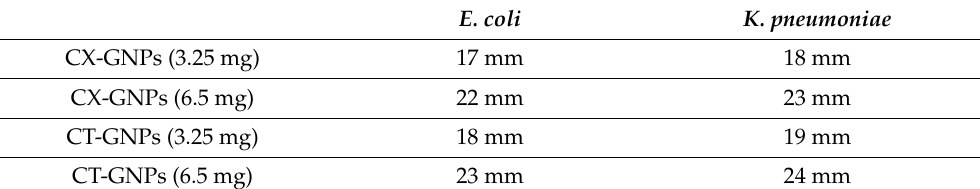
Table 1. : Inhibition zones of CT-AuNPs and CX-AuNPs against E. coli and K. pneumoniae .